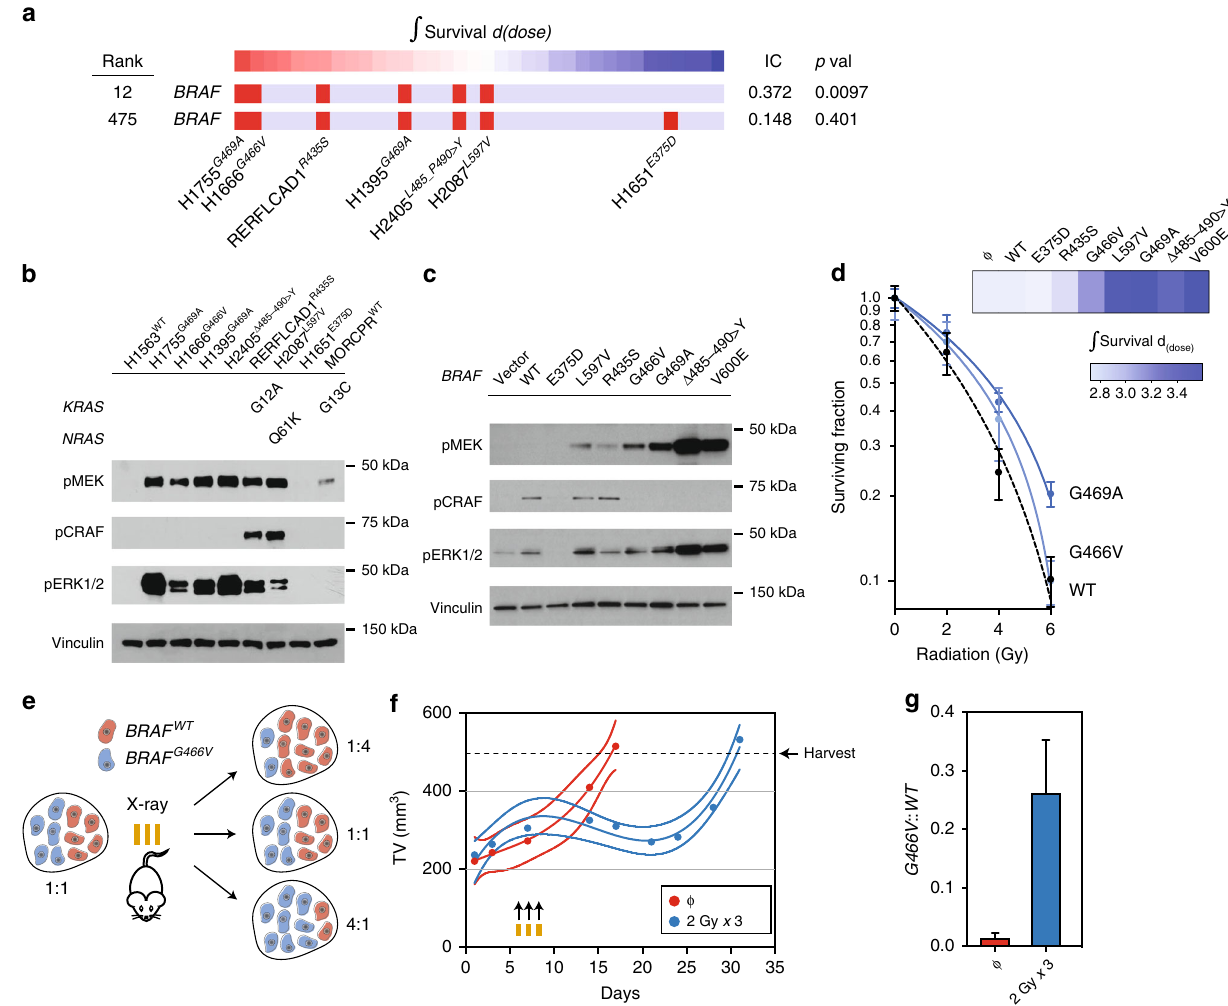
Fig. 6 Hypermorphic BRAF variants confer resistance to genotoxic stress in LUAD. a Association between integral survival and BRAF genotype in 28 LUAD cell lines. Red bar represents mutation. BRAF mutation ranked 12 out of 6743 genomic features after outlier exclusion. The P -values were calculated using the empirical permutation test. b Immunoblot analysis of representative cell lines pro fi led for radiation sensitivity. c BEAS-2B cells stably infected with vector alone ( ϕ ) or vector expressing BRAF variants were pro fi led for RAF-MEK-ERK pathway activity by immunoblot. d BEAS-2B cells in c were treated with ionizing radiation and cell number was determined on days 7 – 9. Representative curves are shown. Data points represent mean ± s.e.m. The heatmap of integral survival is organized by the order of all of the transduced cells in c . e Schematic depiction of the experimental design used in f . f BEAS-2B cells expressing BRAF G466V or wild-type (WT) were injected into the fl ank of NSG mice and block randomized into each treatment arm: Mock ( ϕ ) or X-ray (2 Gy × 3). Tumor volumes were measured at least twice weekly. Data represent the mean. Solid line represents the interpolation of mean using a third order polynomial fi t. Dashed lines represent the 95% con fi dence interval of the polynomial fi t. n = 5 independent animals for each condition. g The ratio of G466V to WT was determined in the harvested tumors (at a volume of ~500 mm 3 ) using ddPCR. The proportion in each arm was normalized to the fractional abundance in cells expressing G466V alone. Data are expressed as the mean ± s.e.m. of three independent